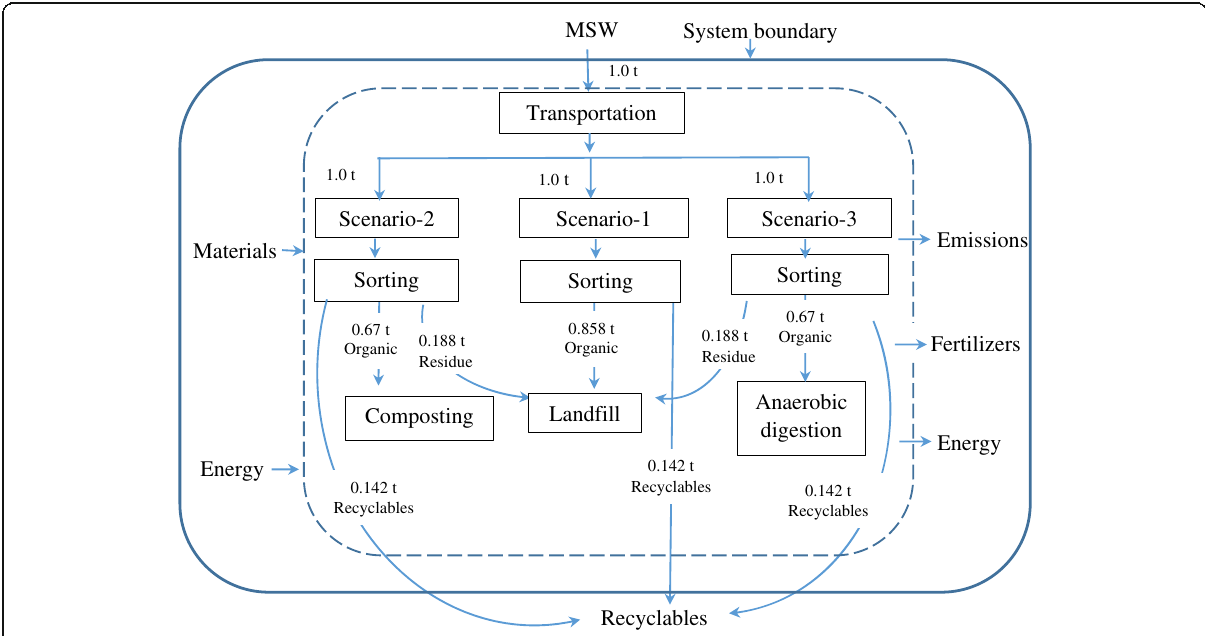
Fig. 1 The system boundary of the